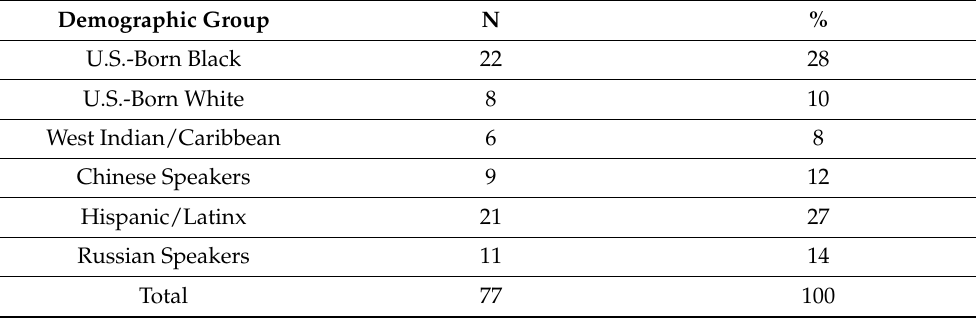
Table 1. Participants’ characteristics by race and